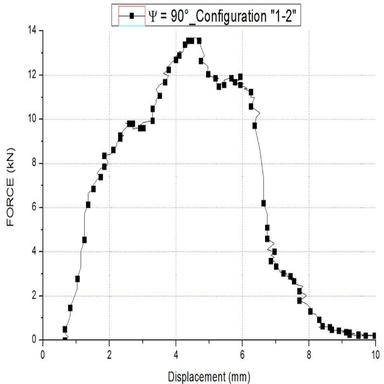
Force vs. displacement for the pure shear test in configuration "1–2" (ψ = 90∘ ).